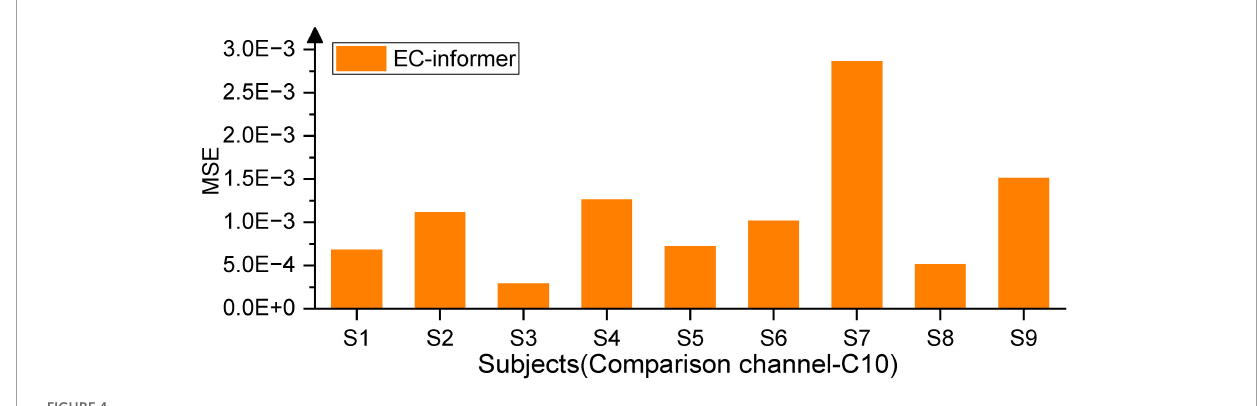
FIGURE4 Evaluation results of complementary channels of